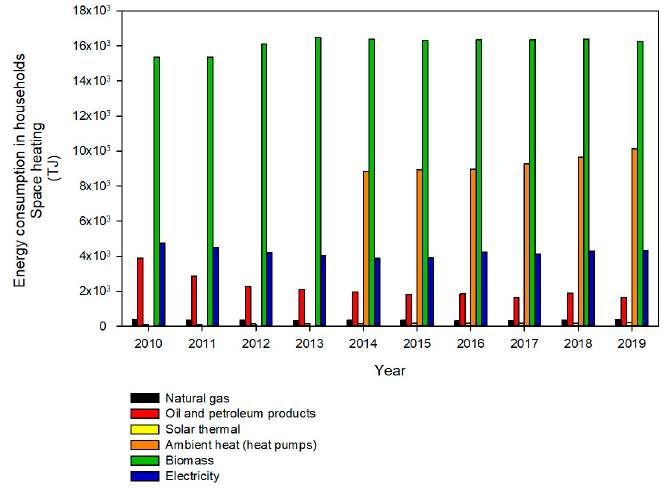
Figure 4. Energy consumption in households for space heating by source (data source [45]).